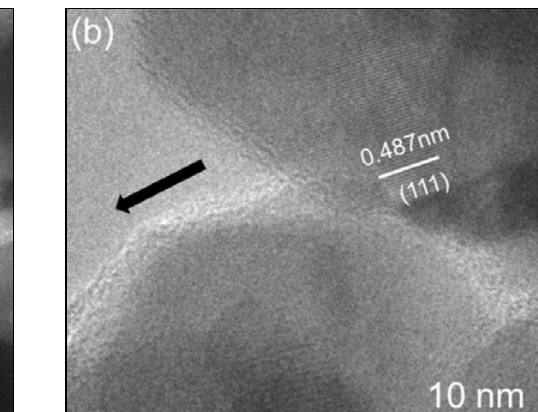
O particles. 2 4